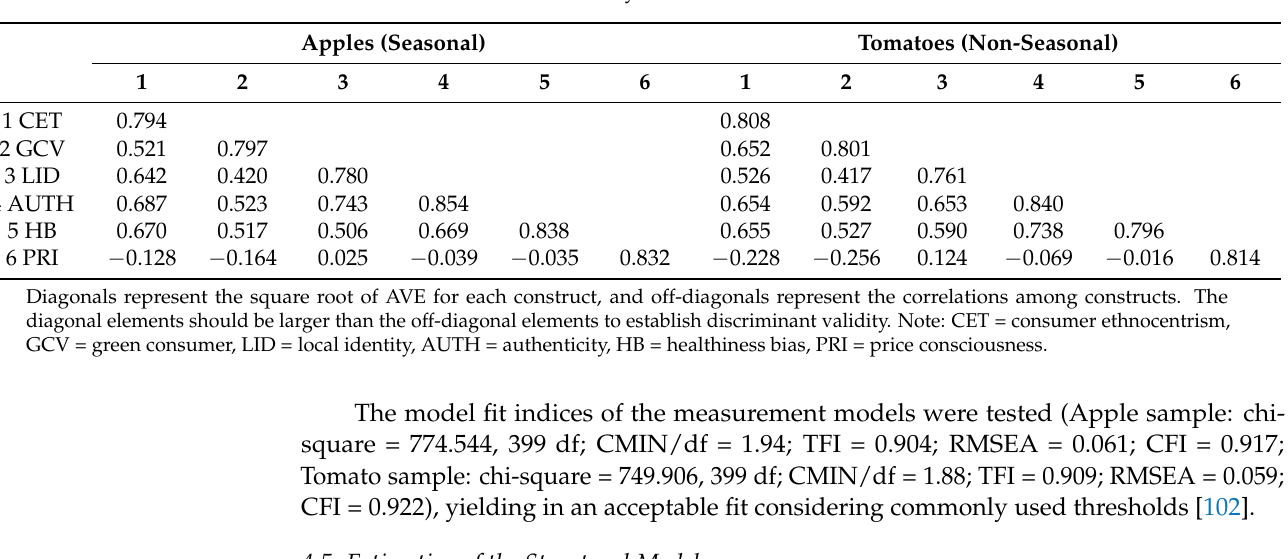
Table 6. Discriminant validity of the measurement